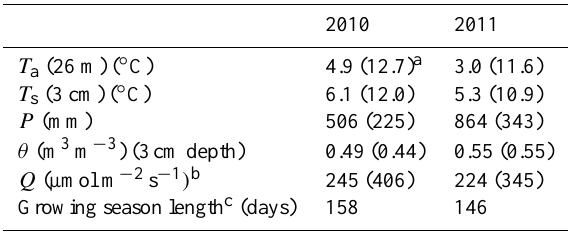
Table 2. Mean annual and growing season climate conditions at MPB-09.